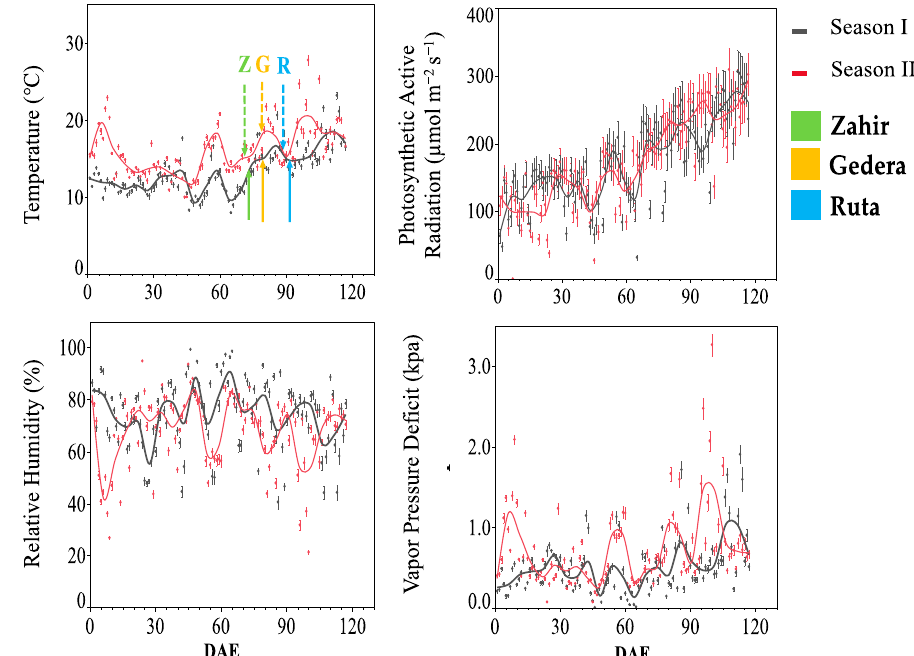
Figure 2. OTC experiment meteorological parameters. Ambient meteorological data from plant emergence to maturity. Presented are 24 h mean temperature, solar global radiation, relative humidity, and vapor pressure deficit vs. days after emergence (DAE). Solid and dotted arrows in the temperature panel indicate the heading of cultivars in season I and season II, respectively. Table 3. O 3 concentrations and AOT40. Daytime 12 h and 7 h O 3 (ppbv) mean (M12, M7), maximum and minimum, and AOT40 (ppmh) from flag leaf emergence to plant maturity in control OTC (OTC-CO), O 3 -enriched OTC (OTC-EO), and ambient air, individually for season I and season II.